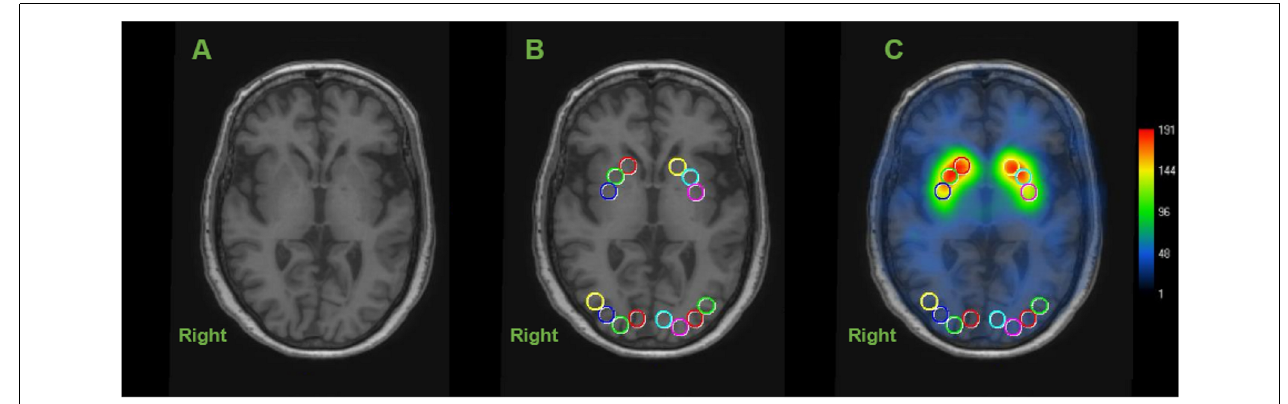
FIGURE 1 | Representative image of regions of interest (ROIs) in dopamine transporter (DAT) image. Circular ROIs were manually placed 10 mm in diameter, in each hemisphere on the structural MRI for the caudate nucleus (CN), anterior putamen (AP) and posterior putamen (PP) and 8 on the occipital cortex as the reference region. Calculating each specific activity with DAT binding is estimated by the striatal-to-occipital ratio, defined as (striatum—occipital)/occipital counts. (A) Axial section of structural MRI (3-dimensional T1 weight image). (B) ROIs placed on an axial slice of MRI. (C) [ 123 I]FP-CIT SPECT image overlaid onto the coregistered MRI.